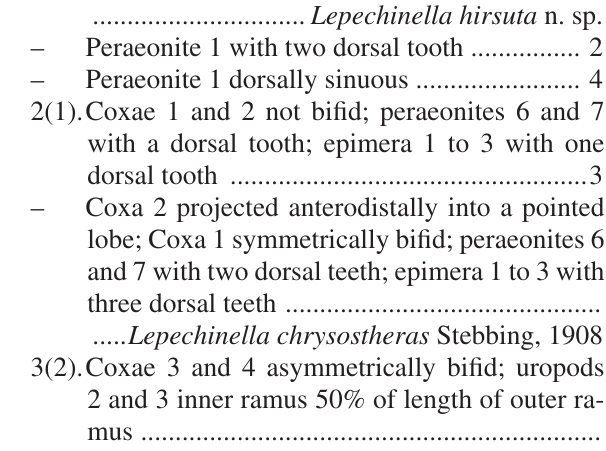
Fig . 9. – Lepechinella laurensi n. sp., holotype, male, 5.7 mm, MnrJ16485, oceanprof ii #58, 21°57’26.8”S, 39°40’34.0”w. Scale bars = 0.1